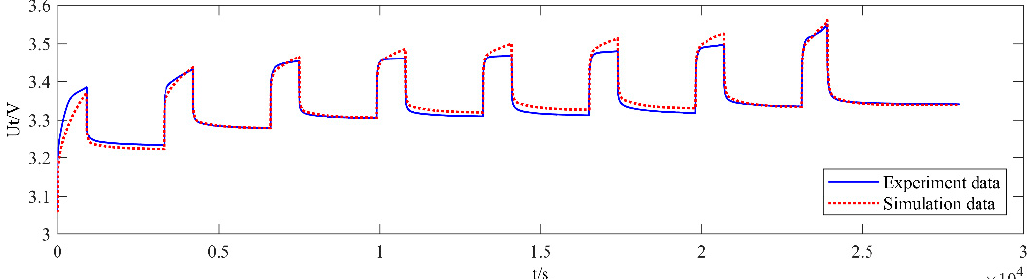
Figure 5. Comparison of 10 A variable current charging experimental results and battery model simulation results.